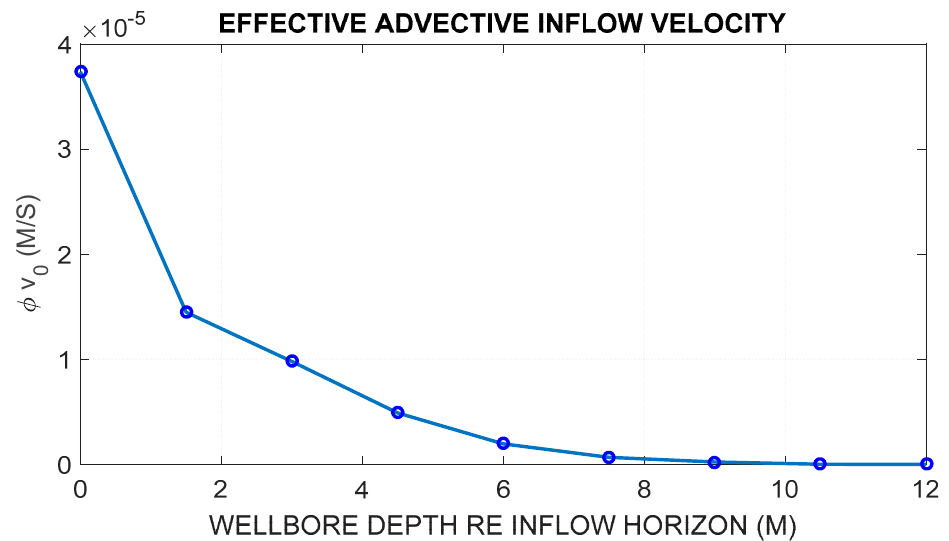
Figure 12. Effective inflow velocity φ v 0 = P e D/r 0 at successive wellbore offsets from the inflow horizon given by the Figures 7–11 model of OTN1 temperature event at depth 1218 m. For crustal rock of mean porosity φ = 0.01, the computed inflow Darcy fluid velocity at wellbore radius 30 cm is v 0 ~ 4 mm/s across a 1 m wellbore depth